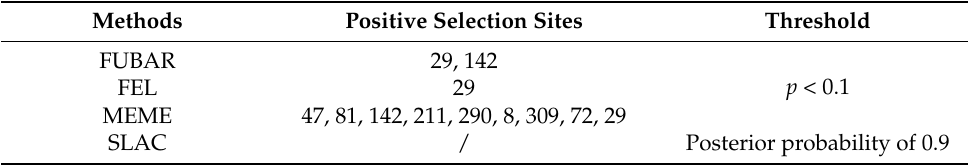
Figure 6. Recombination analysis of PCLV. PCLV-AH-23 was the query sequence, and the major and minor parents were strain PCLV-AH-25 (accession number: MZ773068/China) and Po-Circo-like virus 21 (accession number: JF713716.1/USA). The red curve represents the similarity of strain Po-Circo-like virus 21 to strain PCLV-AH-23. The green curve represents the similarity of strain PCLV-AH-25 to strain PCLV-AH-23. Rep is the potential recombination region. Recombination events were identified using seven methods in the Recombination Detection Program v.4.39 (RDP 4.39), namely, RDP, GENECONV, Chimaera, MaxChi, BootScan, SiScan and 3Seq. The SimPlot software v.3.5.1 was used for the analysis with visual similarity plots using a window size of 200 nucleotides that was moved along in 20 nt steps. Table 1. Positive selection site for three genotypes of